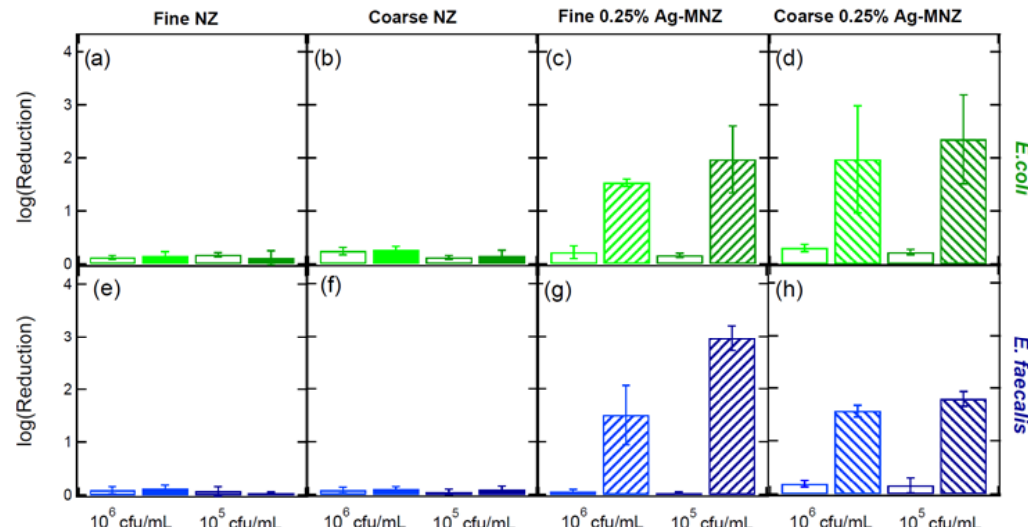
Figure 6. Calculated log-reduced values of E. coli ( a – d ) and E. faecalis ( e – h ) in controls (empty columns) and interacting with fine (0 – 1 mm) ( a , e ) and coarse (1 – 3 mm) ( b , f ) NZ (filled columns), and fine (0 – 1 mm) ( c , g ) and coarse (1 – 3 mm) ( d , h ) Ag-MNZ (cross-shaded columns) for bacterial initial concentrations: 10 6 and 10 5 cfu/mL within 1 h of experiment. Table 2. Calculated log and percent reduction values of E.coli and E. faecalis in the presence of NZ and 0.25% Ag-MNZ within the period of 1 h under the experimental conditions. Experimental